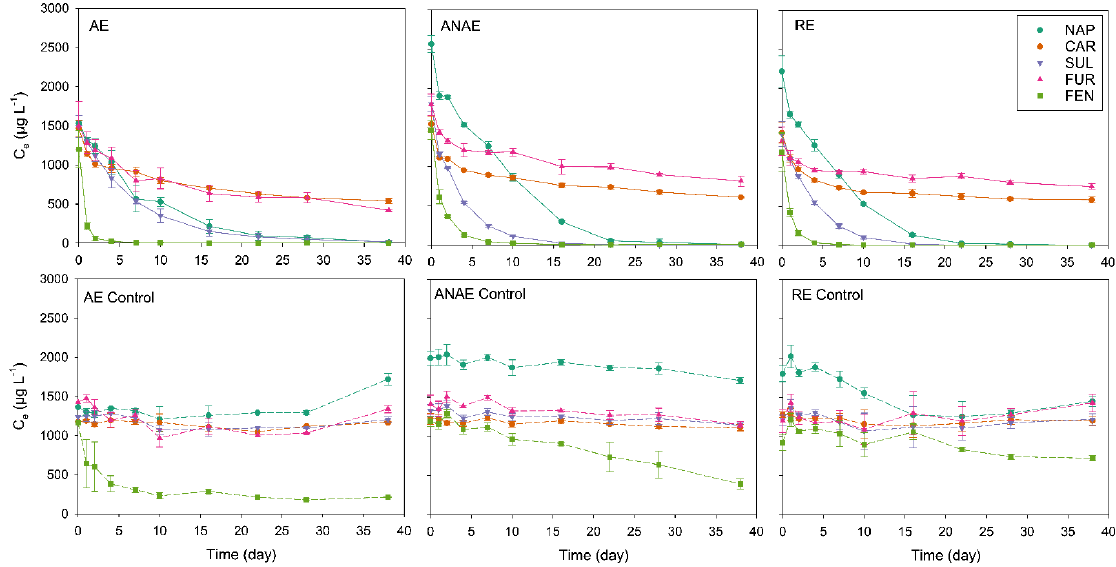
Figure 4. The measured concentration of pharmaceuticals in the water phase in the aerobic (AE), anaerobic (ANAE) and undisturbed microcosms (RE).